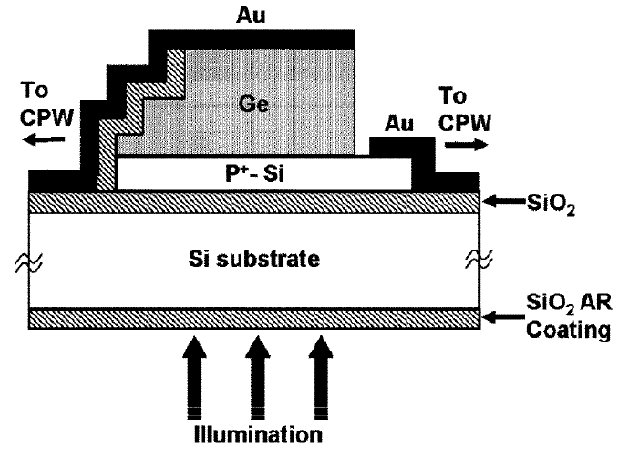
Figure 4. Cross-sectional view of the back-illuminated Ge-SOI Schottky photodetector. From